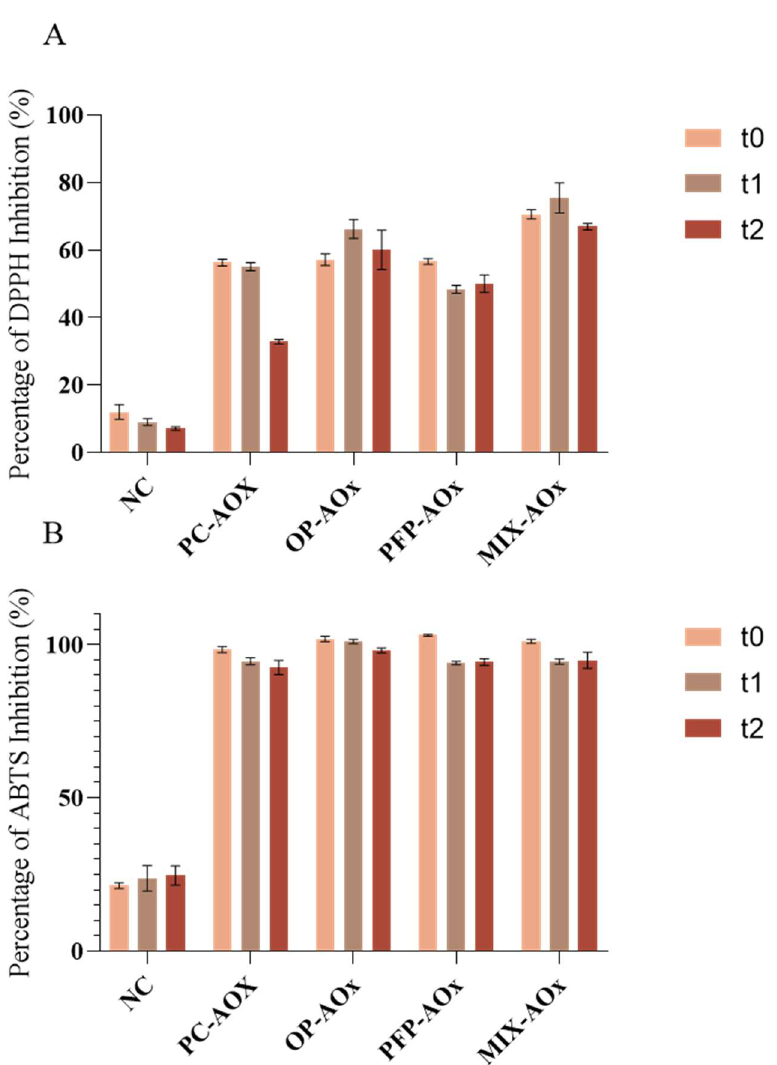
Figure 8. Results were obtained for ( A ) assay with DPPH radical and ( B ) assay with ABTS radical. The analysis was performed for three study times: t 0 —week of production; t 1 —two weeks after pro- duction; t 2 —four weeks after production. NC: negative control; PC-AOx: positive antioxidant control; OP-AOx: onion peel extract antioxidant sample; PFP-AOx: passion fruit peel extract antioxidant sample; Mix-AOx: mixture of antioxidant control and OP and PFP extract.